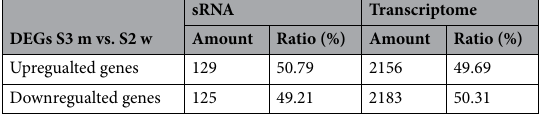
Table 3. Statistics of the genes expression with significant